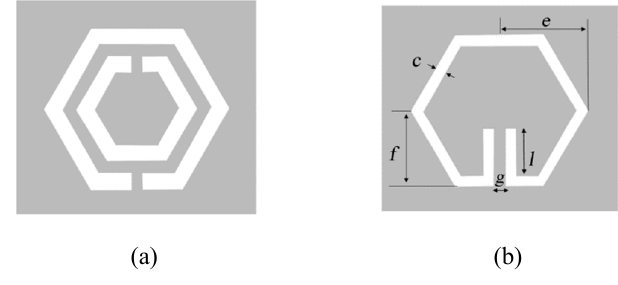
FIGURE 1. Diagrammatic sketch of (a) C-HSRR and (b) C-HMC